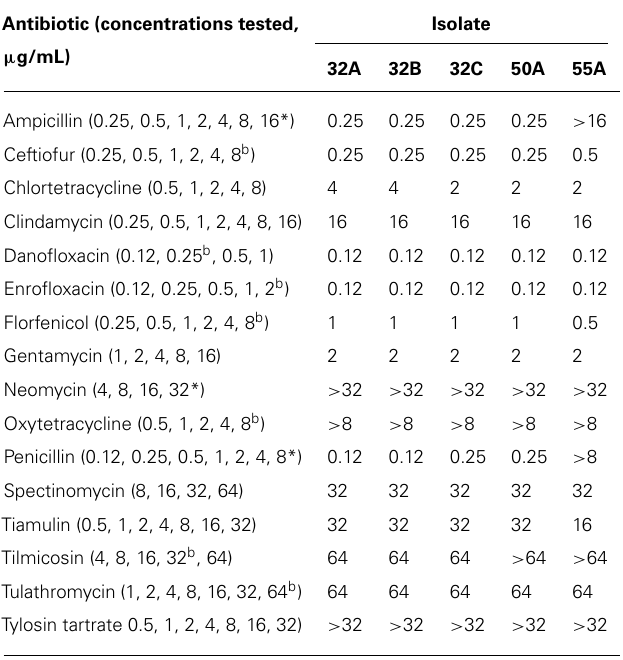
a Isolateswerefirstscreenedforreducedtulathromycinsusceptibilitybyculturing onto BHI plates supplemented with tulathromycin (2 μ g/mL). b Breakpoints defining resistance (CLSI, 2008). *Resistance breakpoint defined by